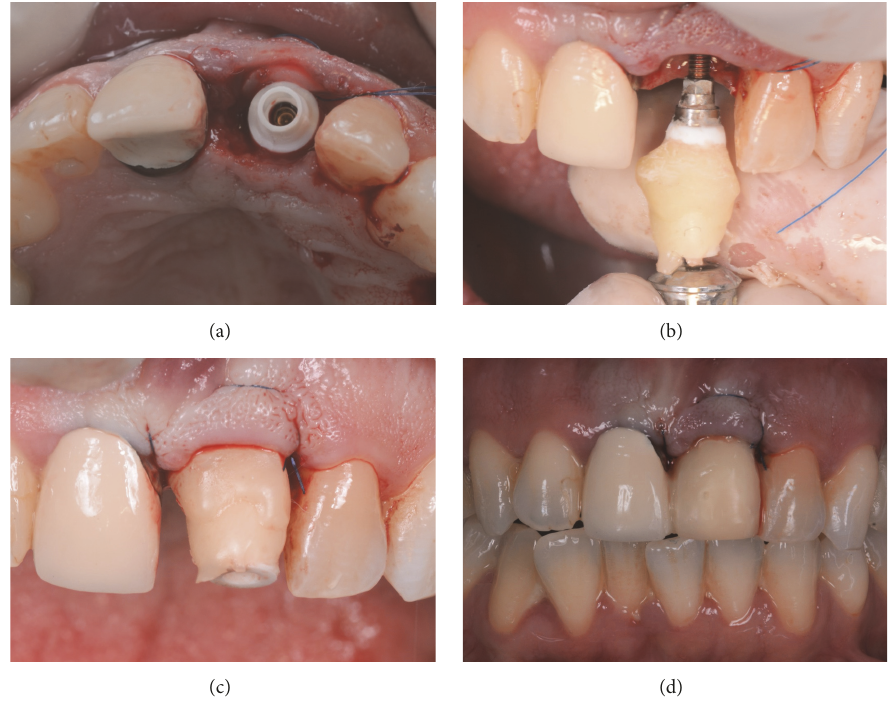
Figure 5: Immediate provisionalization. A provisional abutment is screwed on the implant (a) and the individual emergence profile is obtained with composite resin (b) in order the correct pressure that is exerted on the soft tissues (c); in this case, the immediate temporary restoration is then splinted to the adjacent teeth, for a short period after the surgery, in order to reduce the effects of prosthetic loading on the immediately inserted implant (d).